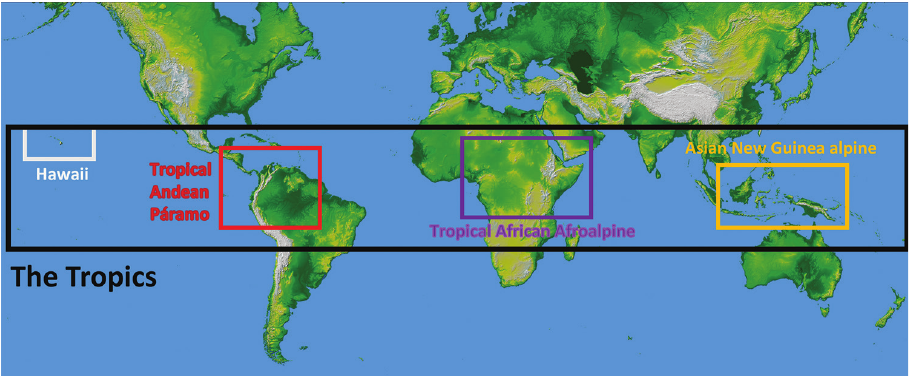
Figure 1. Location of the tropical alpine-like climate regions in the Tropics on a Mercator projection of the world with shaded relief and coloured height based on SRTM data with 1 arc second resolution. Credit: NASA/JPL/NIMA downloaded from http://photojournal.jpl.nasa.gov/catalog/PIA03395. De- tailed maps for each region are included in the Suppl. material 3 (figures